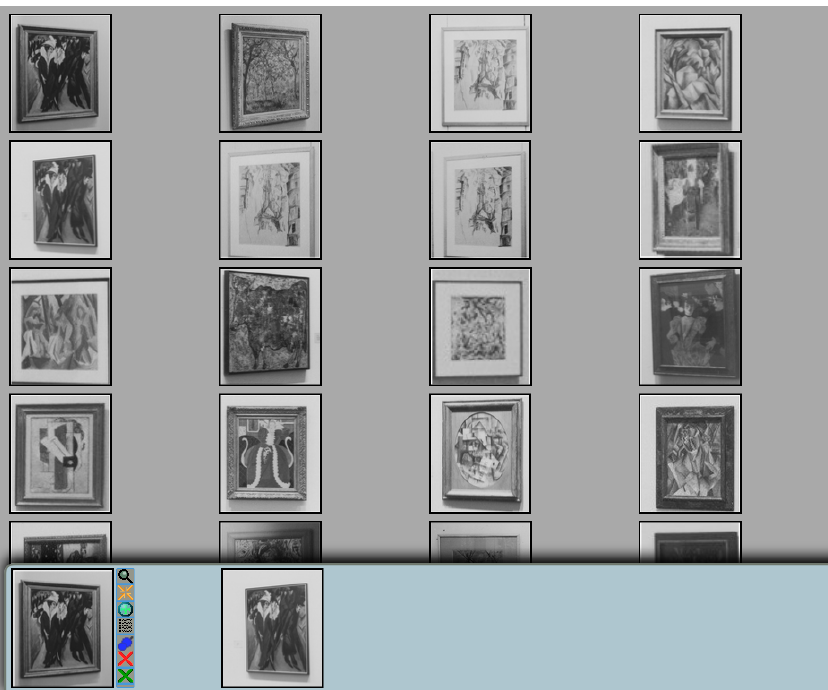
Figure 11. Search results for Ernst Ludwig Kirchner’s ’Street, Berlin’, 1913. Image rights: Computer Vision Group, Heidelberg University. Displayed photographs/details belong to the Museum of Modern Art, New